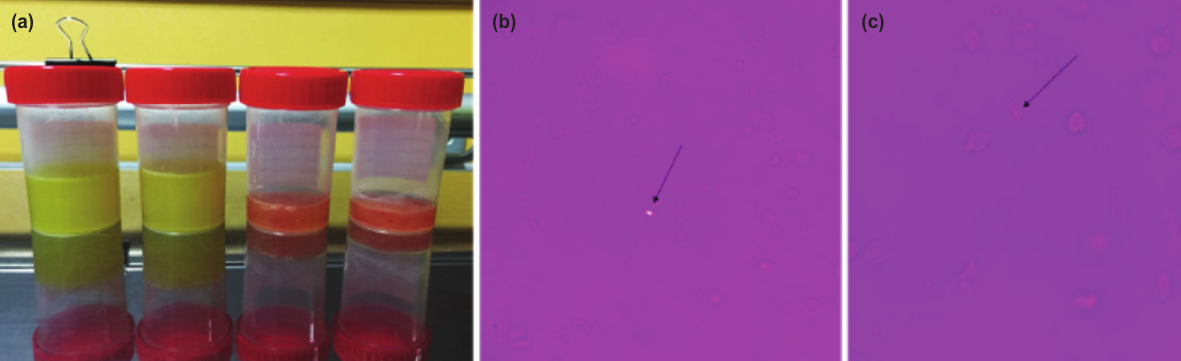
(a) Knee joint aspiration showed turbid fluid (all the four bottles are from the same knee). (b) Gout crystal (strongly negative Fig. 2: birefringent needle-like crystals). (c) Pseudogout crystal (weakly positive birefringent rhomboid shaped